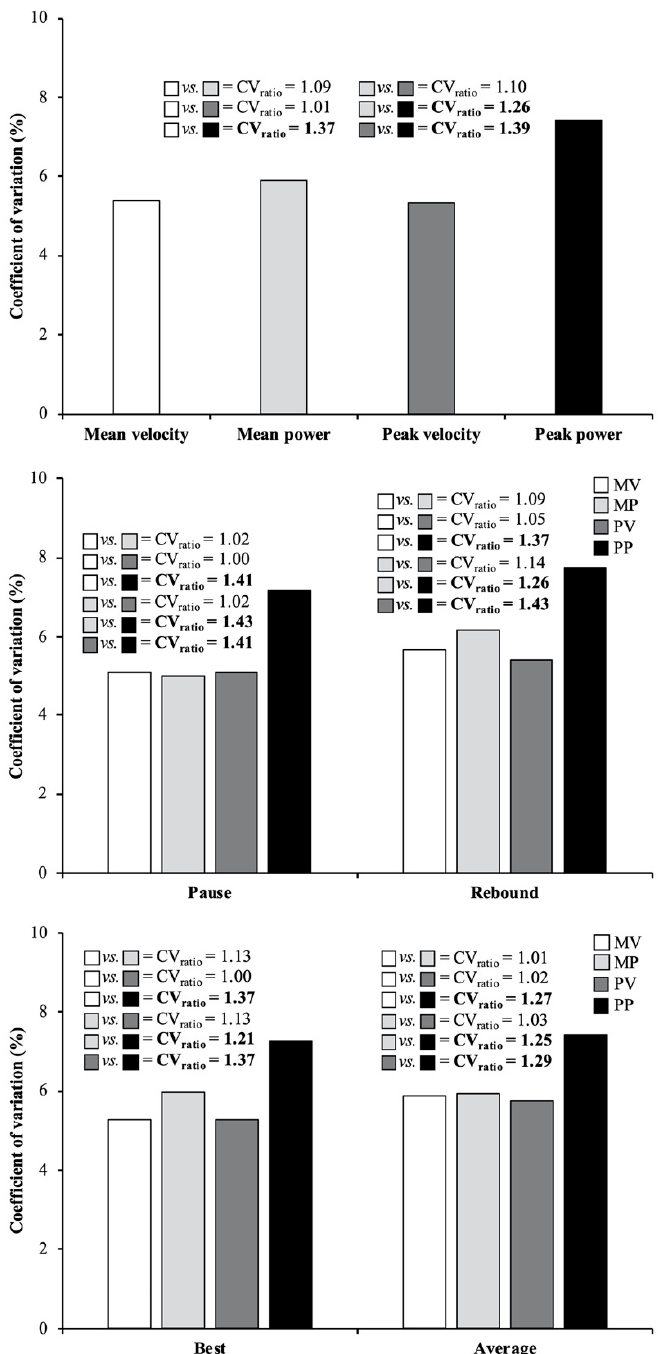
Figure 1. Reliability comparisons between mean velocity (MV; white bars), mean power (MP; light gray bars), peak velocity (PV; dark gray bars), and peak power (PP; black bars) variables collected during the back-squat exercise. Bars represent the median coefficient of variation value obtained combining the 2 exercise techniques and 2 repetition criteria (upper panel), the 2 repetition criteria separately for each exercise technique (middle panel), and the 2 exercise techniques separately for each repetition criterion (lower panel). Numbers depict the ratio between 2 coefficients of variation (CV ratio = higher/lower value), while meaningful differences in reliability are indicated in bold (CV ratio > 1.15).